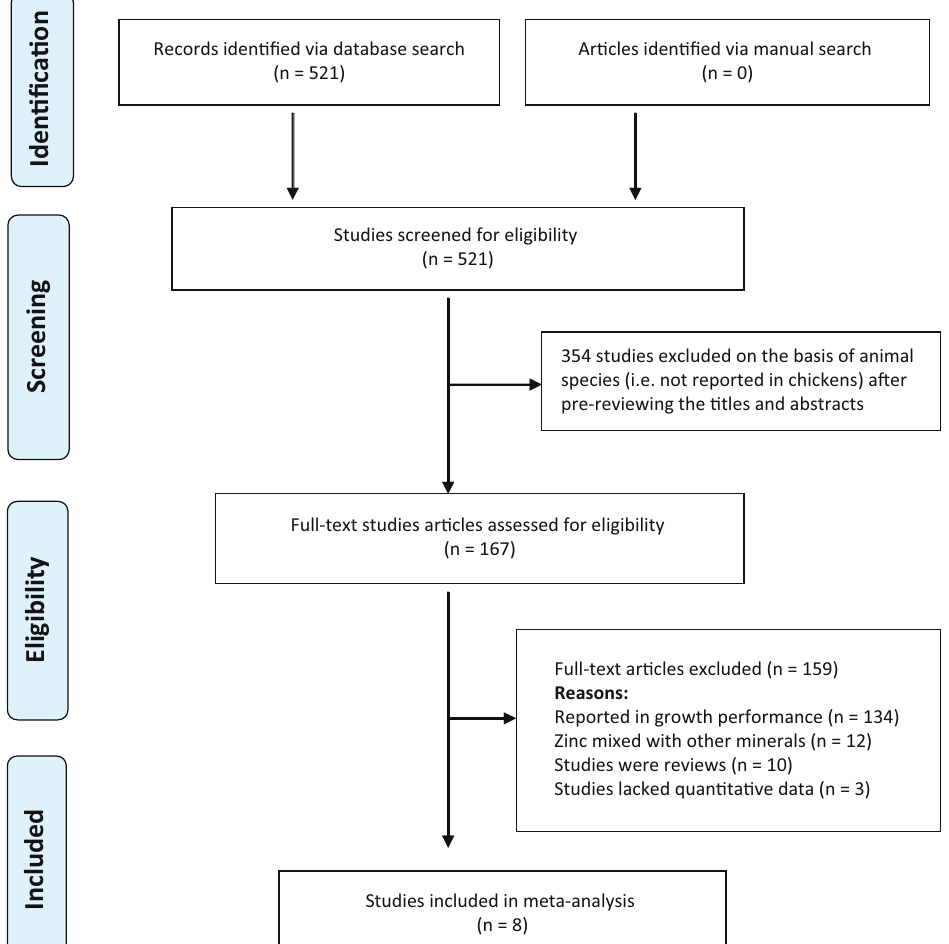
Figure 1: Flowchart of the article selection process for the meta -